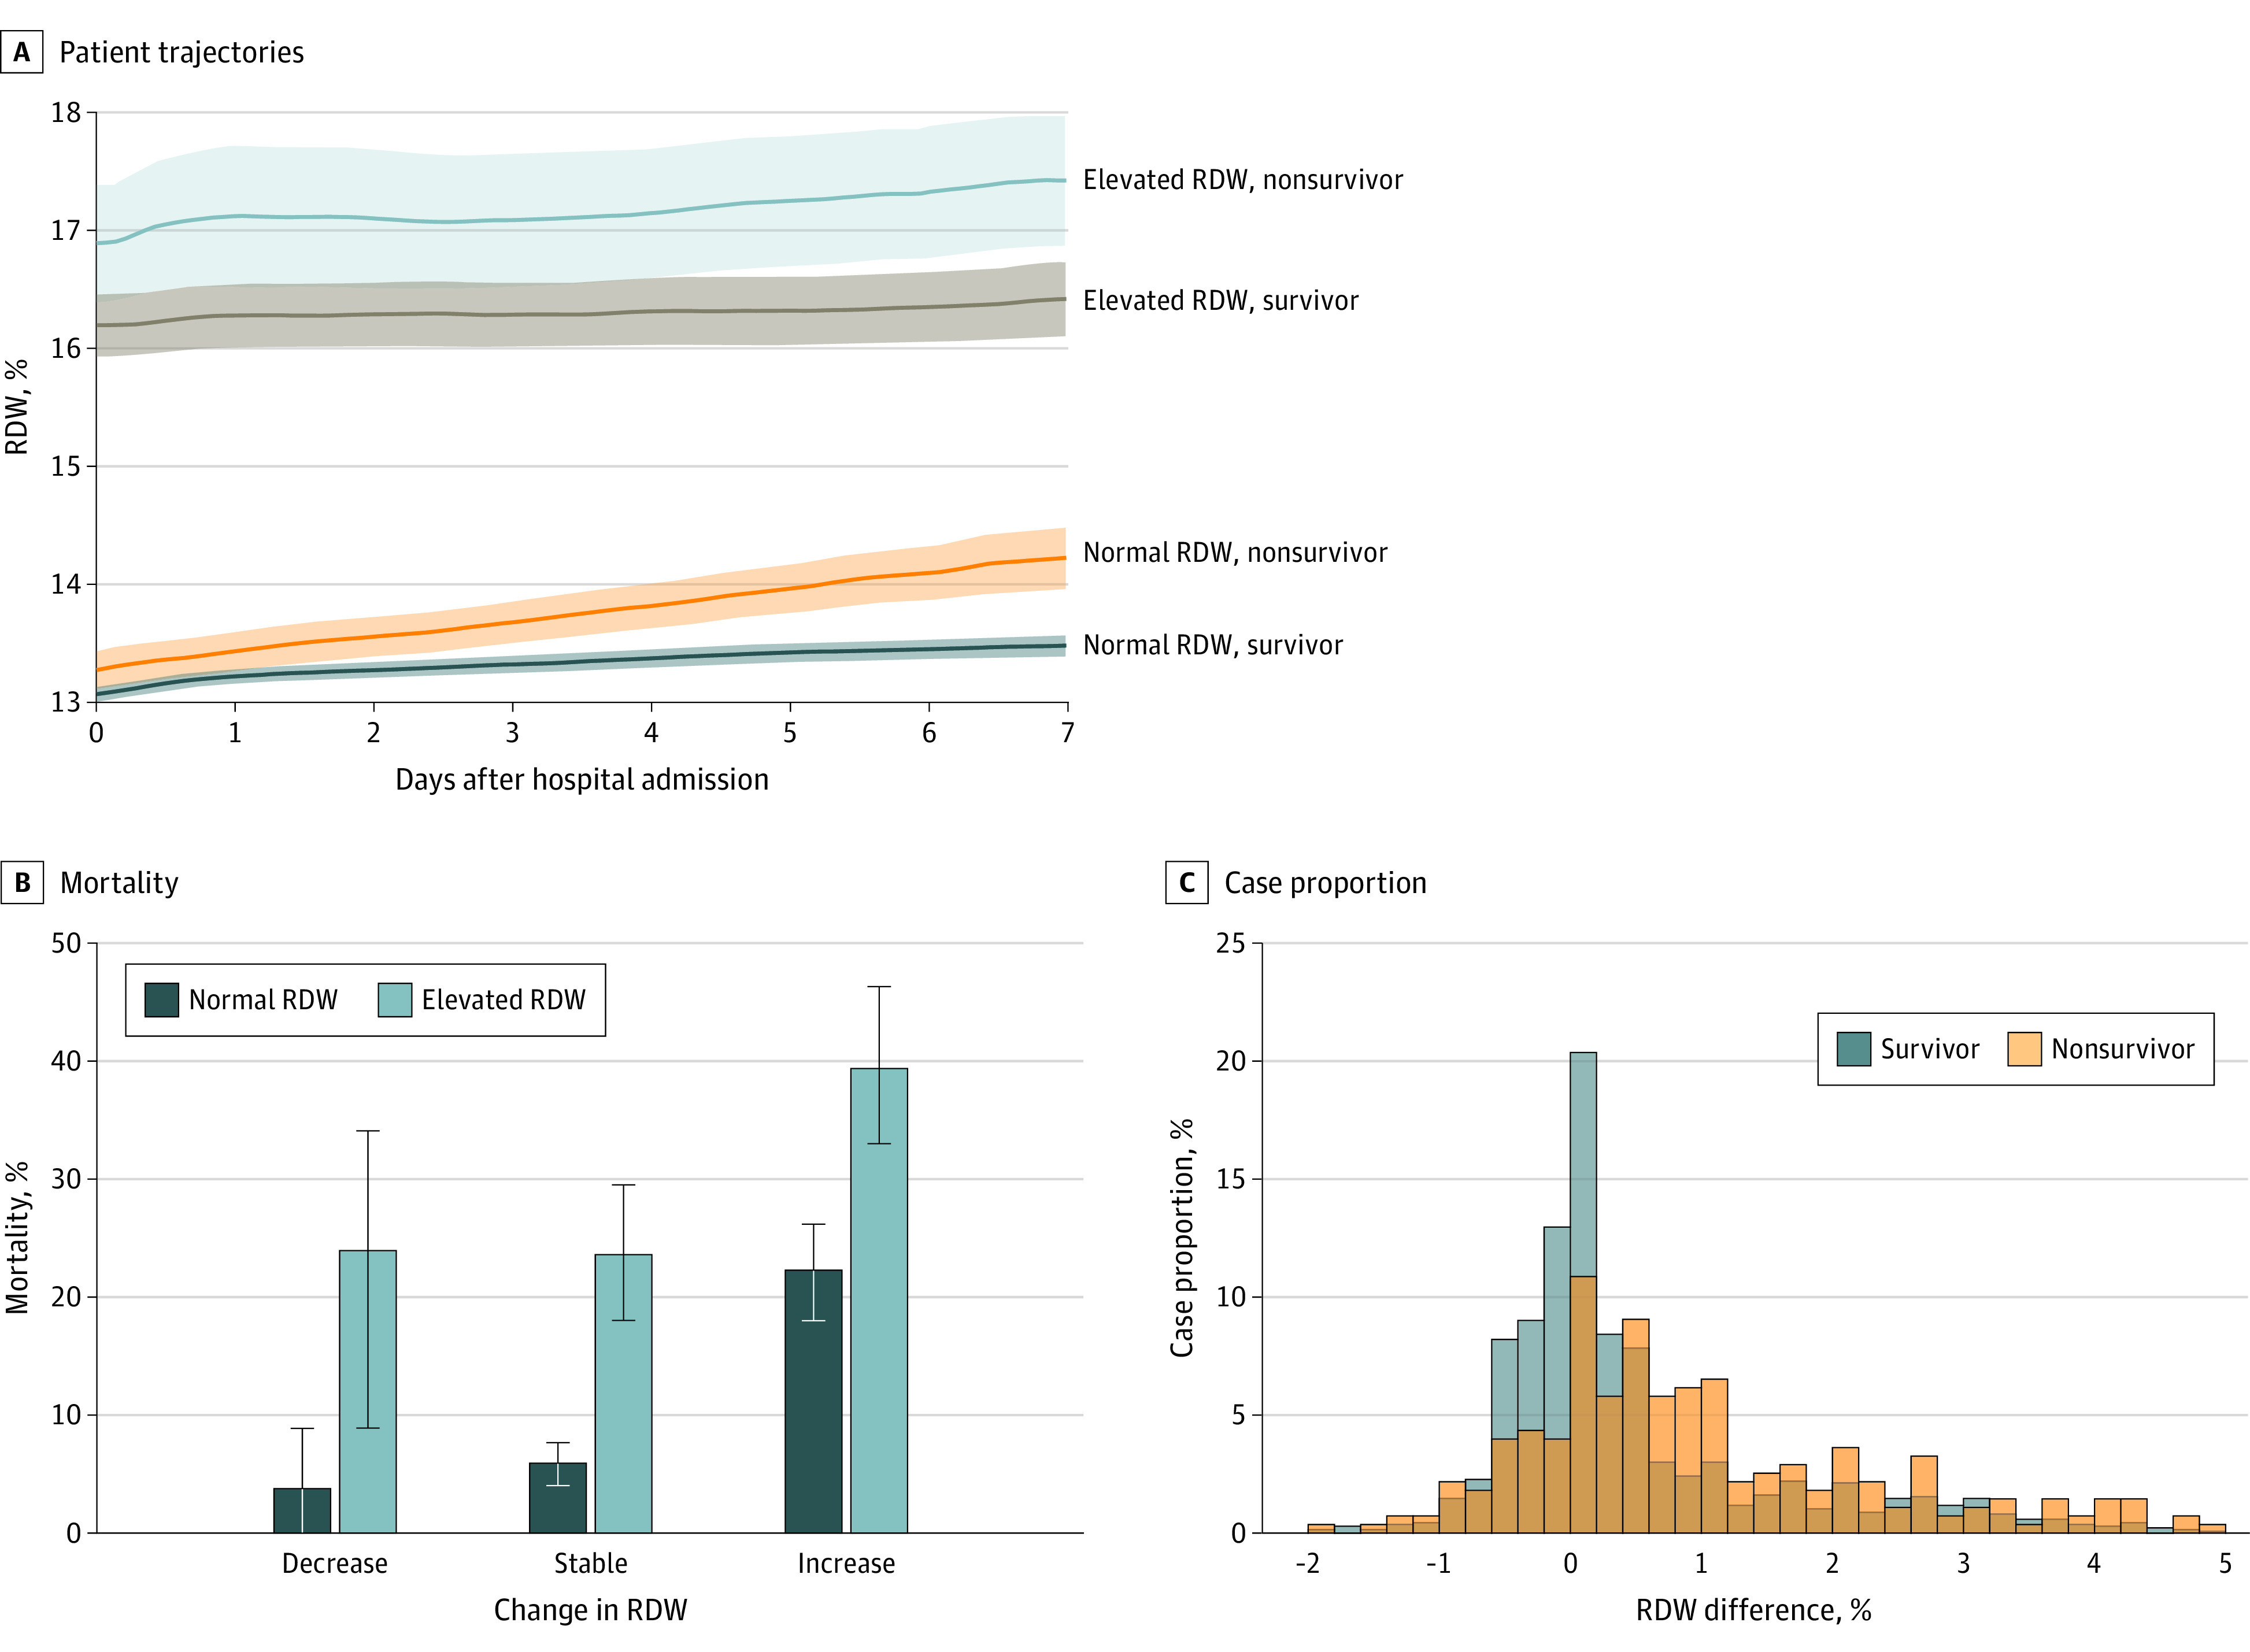
Red Blood Cell Distribution Width (RDW) Increase After Admission and Mortality Risk Among Patients With Coronavirus Disease 2019A, Stratifying patients based on admission RDW and mortality reveals that, among patients with an RDW of 14.5% or less at admission, those who do not survive have an average RDW increase of 1.5% during their first week of hospitalization, a significantly larger RDW increase than in all other groups. Shading represents the 95% CI. B, Among patients with an RDW of 14.5% or less at admission, those with an increase of more than 0.5% in RDW between admission and discharge had a 24% (95% CI, 18%-30%) mortality rate compared to 6% (95% CI, 4%-8%) for those with stable RDW (≥−0.5% and ≤0.5%). Among patients with elevated RDW at admission, a further increase in RDW during admission was associated with a mortality rate of 40% (95% CI, 33%-47%), and a stable elevated RDW was associated with a mortality rate of 22% (95% CI, 18%-26%). C, A histogram of RDW change in survivors and nonsurvivors of coronavirus disease 2019 shows that nonsurvivors were more likely than survivors to experience an RDW increase during hospitalization. Change in RDW is reported in percentage points. For instance, a change in RDW from 14.0% to 15.0% is reported as 1.0%.